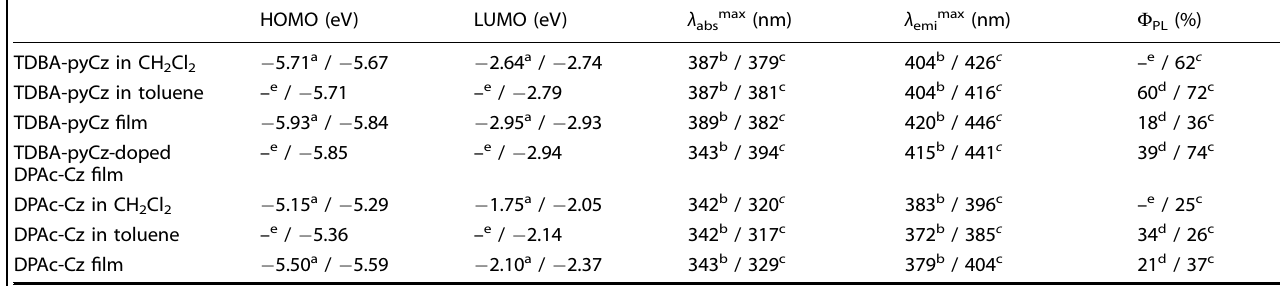
Table 1. DeepHL-predicted HOMO and LUMO energies and DLOS-predicted optical and photophysical properties of TDBA-pyCz and DPAc-Cz (Experiment /